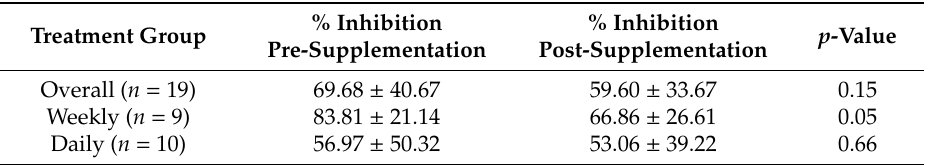
Table 4. Inhibition of HIV-1 by cervicovaginal lavage (CVL) fluids at pre- versus post-vitamin D supplementation.